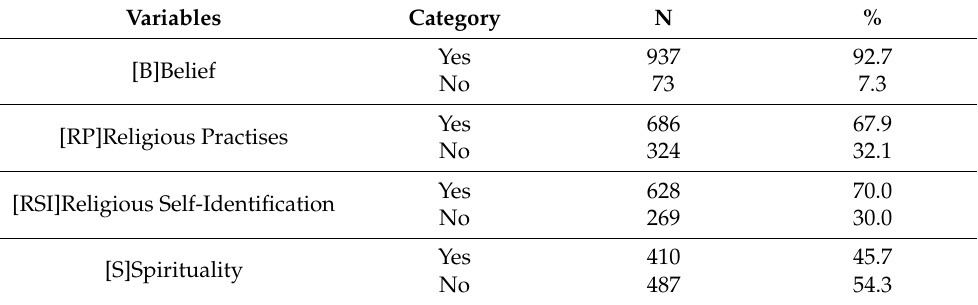
Table 2. The results of summary statistics for religiosity. Variables